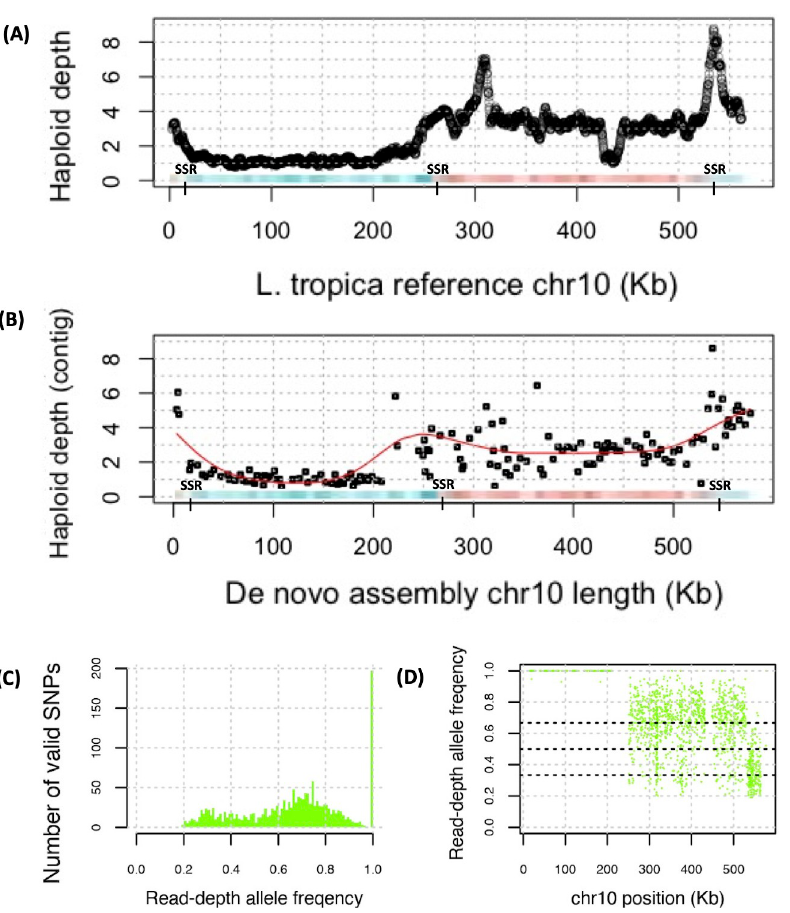
Fig 7. The normalised haploid depth (top) from read mapping to the L . tropica reference genome and for the contigs from a de novo assembly of 14_00642 (middle). Chromosome 10 potentially has three strand-switch regions (SSRs) inferred from experiments in L . major (red and blue panel). The lower panels show the numbers of valid SNPs (bottom left, green) and the RDAF for 14_00642. [81] (Fig 7). 14_00642’s pattern of low heterozygosity and LROHs was not in the other isolates except 15_02480, which had a LROH at > 520 Kb, but had uniform disomy, like the other 20 samples (S12 Fig). The 230–250 Kb region contained numerous reference genome gaps and